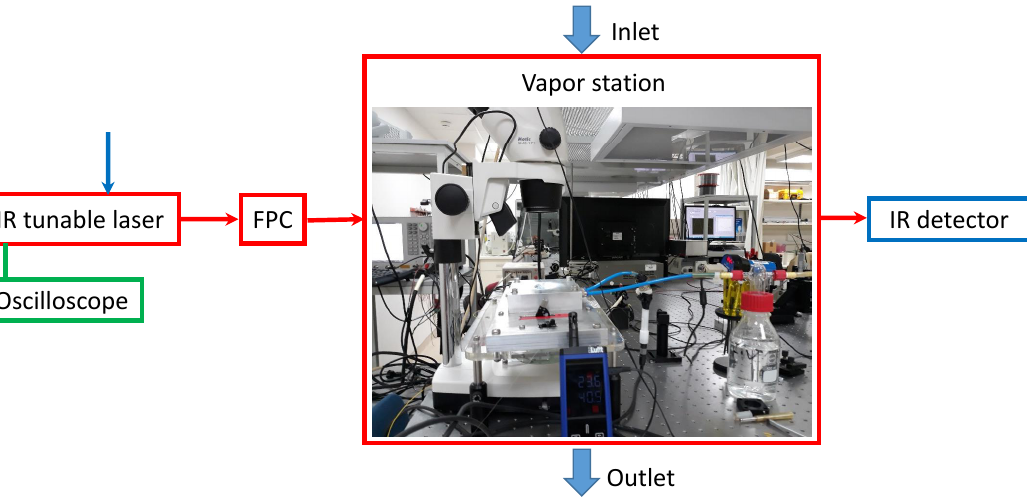
Figure 3. Schematics of the experimental setup including vapor measurement station: FPC–input light fiber polarization controller. Arrows above and below are showing the inlet and outlet of the vapor gas mixed in N 2